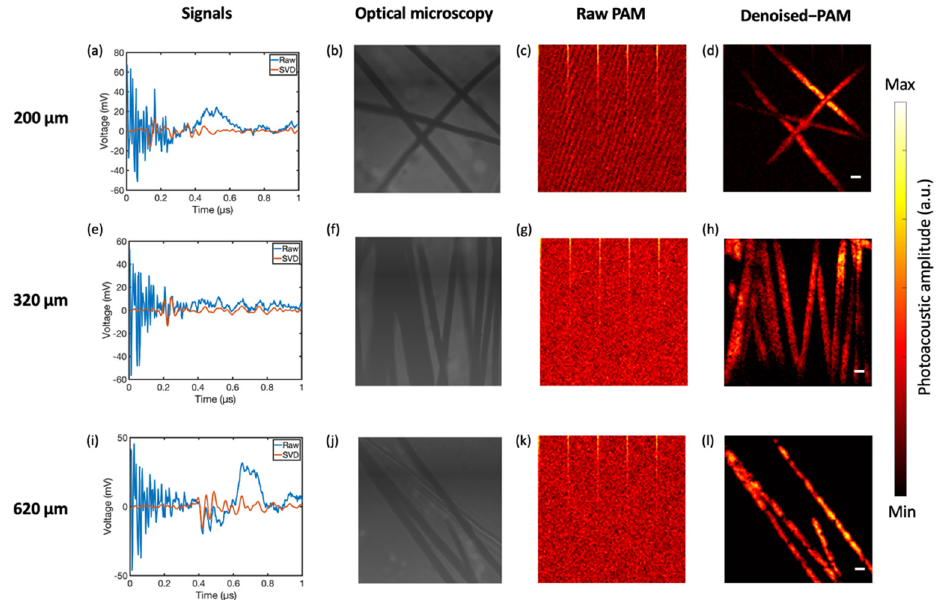
Figure 5. Examples of photoacoustic microscopy (PAM) images of carbon fibres acquired with the developed imaging probe. Images on the left column are detected ultrasound signals before and after the singular value decomposition (SVD) denoising at different imaging planes with the distance from the probe tip of 200 µm ( a ), 320 µm ( e ) and 620 µm ( i ). ( b , f , j ) are optical microscopy images of carbon fibre networks at different imaging planes. The right two columns are PAM images before and after SVD denoising at 200 µm ( c , d ), 320 µm ( g , h ) and 620 µm ( k , l ). Scale bars represent 10 µm.